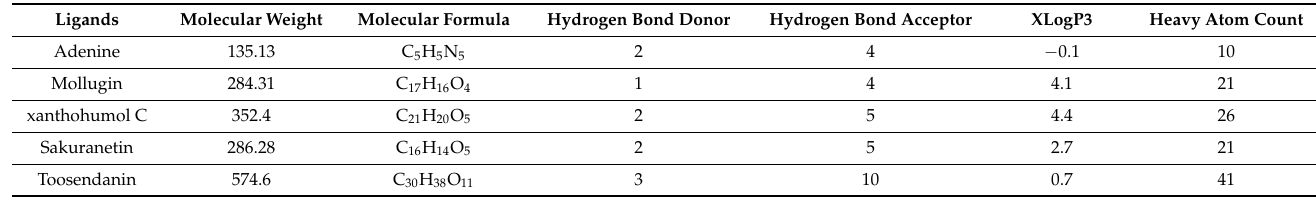
Table 5. Drug-likeness properties of potential